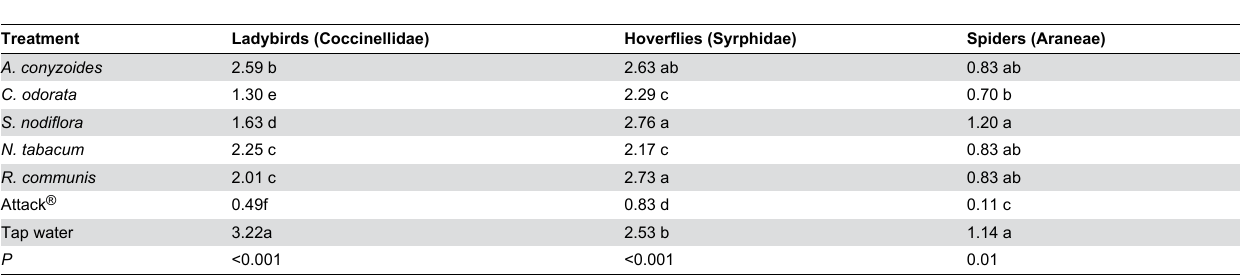
Table 3. Effect of plant extracts and synthetic insecticide on mean numbers of natural enemies per plot in a field experiment during the major rainy season, 2012 at Kumasi, Ghana.